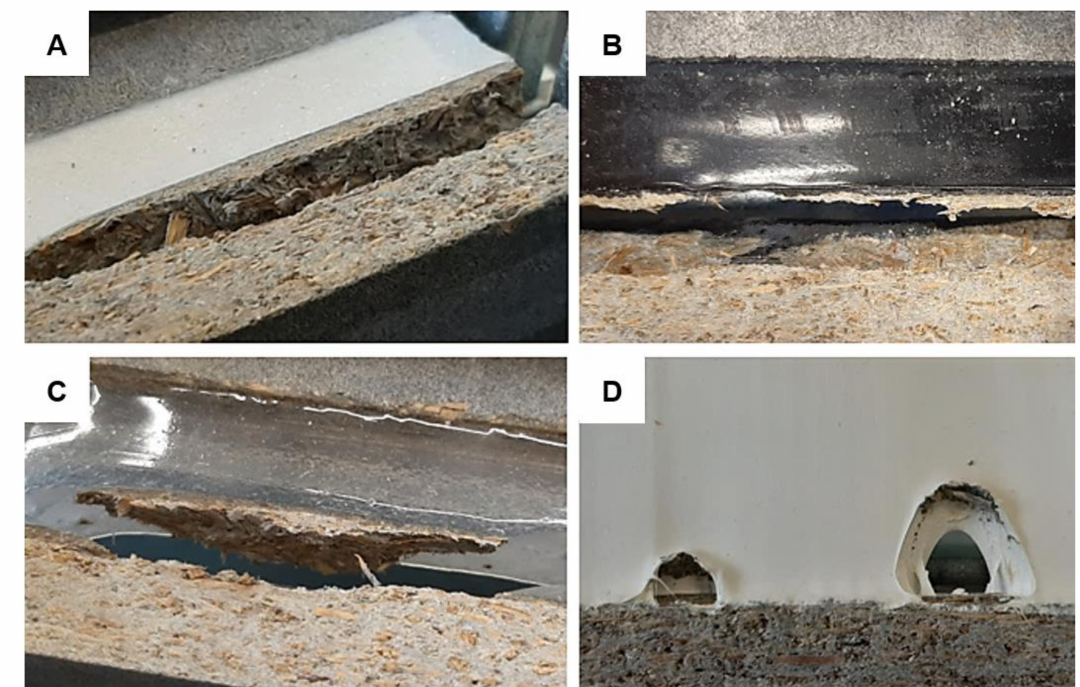
Figure 11. Examples of typical failure modes monitored with design B: ( A ) fiber-tear failure (FTF)